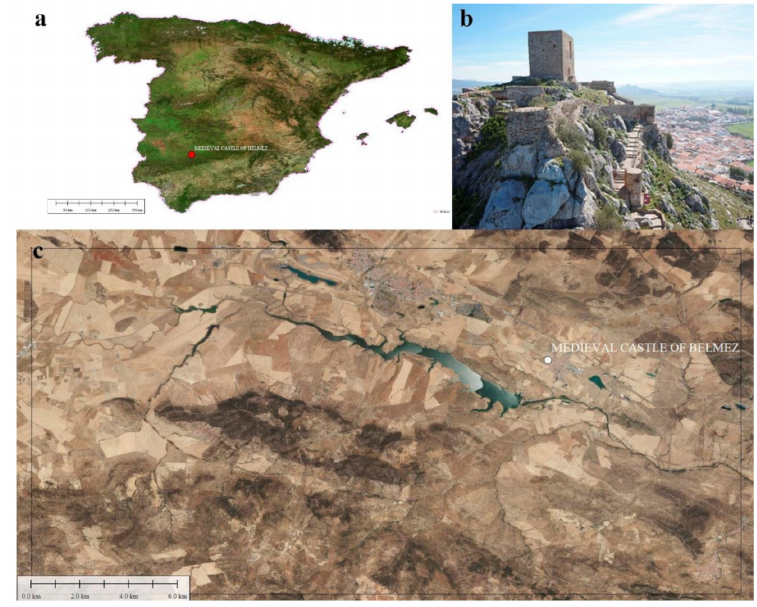
Figure 1. ( a ) Location of the medieval Castle of Belmez. ( b ) Panoramic view from the Cerro del Castillo of Belmez. ( c ) Area surrounding the castle shown using Virtual Reality imaging. Copyright “Ager Mellariensis” / AEI FEDER HAR